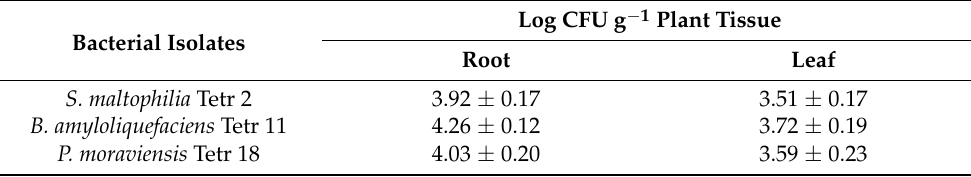
Table 4. The colonization of bacterial isolates in root and leaf tissues of Tetragonia tetragonioides 21 days after